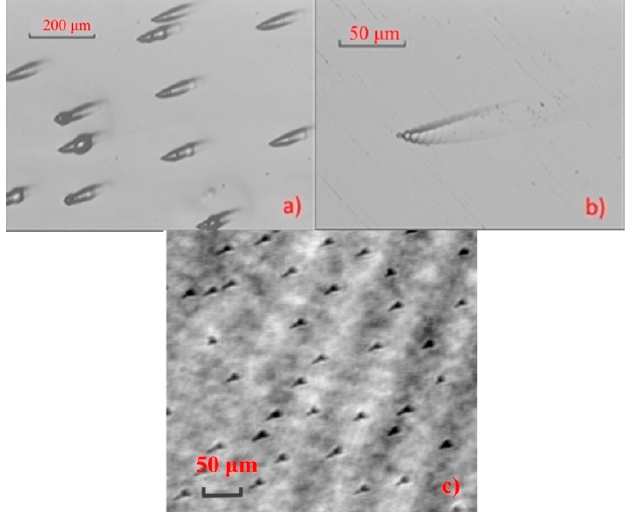
Figure 3. Images of the etched cut tilted to the crystal growth axis at indicated zooming ( а , b ) and image of the cut tilted to the crystal growth axis reconstructed from the hologram ( c ).